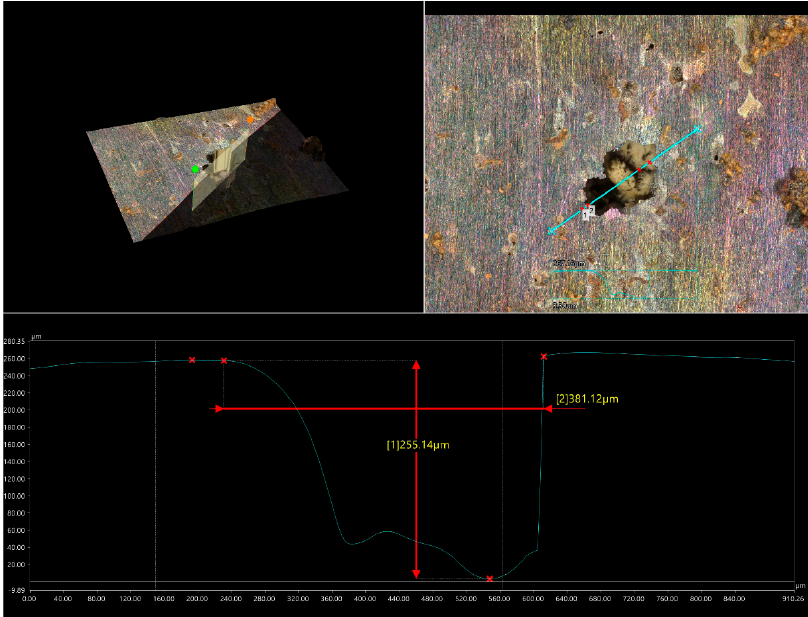
Figure 13. The measured dimensions of the selected pitting location.